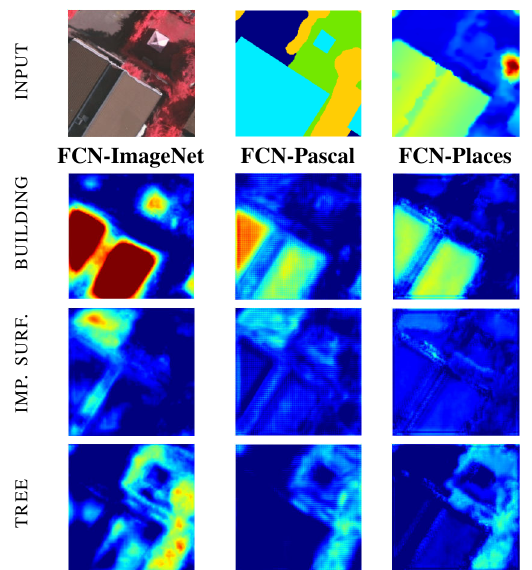
Figure 4: Score maps for classes building , impervious surface , low vegetation , and tree of the three pre-trained models using the input in the top row (red: high score, blue: low score). part be caused by the features’ increased location uncertainty af- ter pooling and deconvolution. We assert that a further reason could be the inherent inaccuracy of the annotated training data.